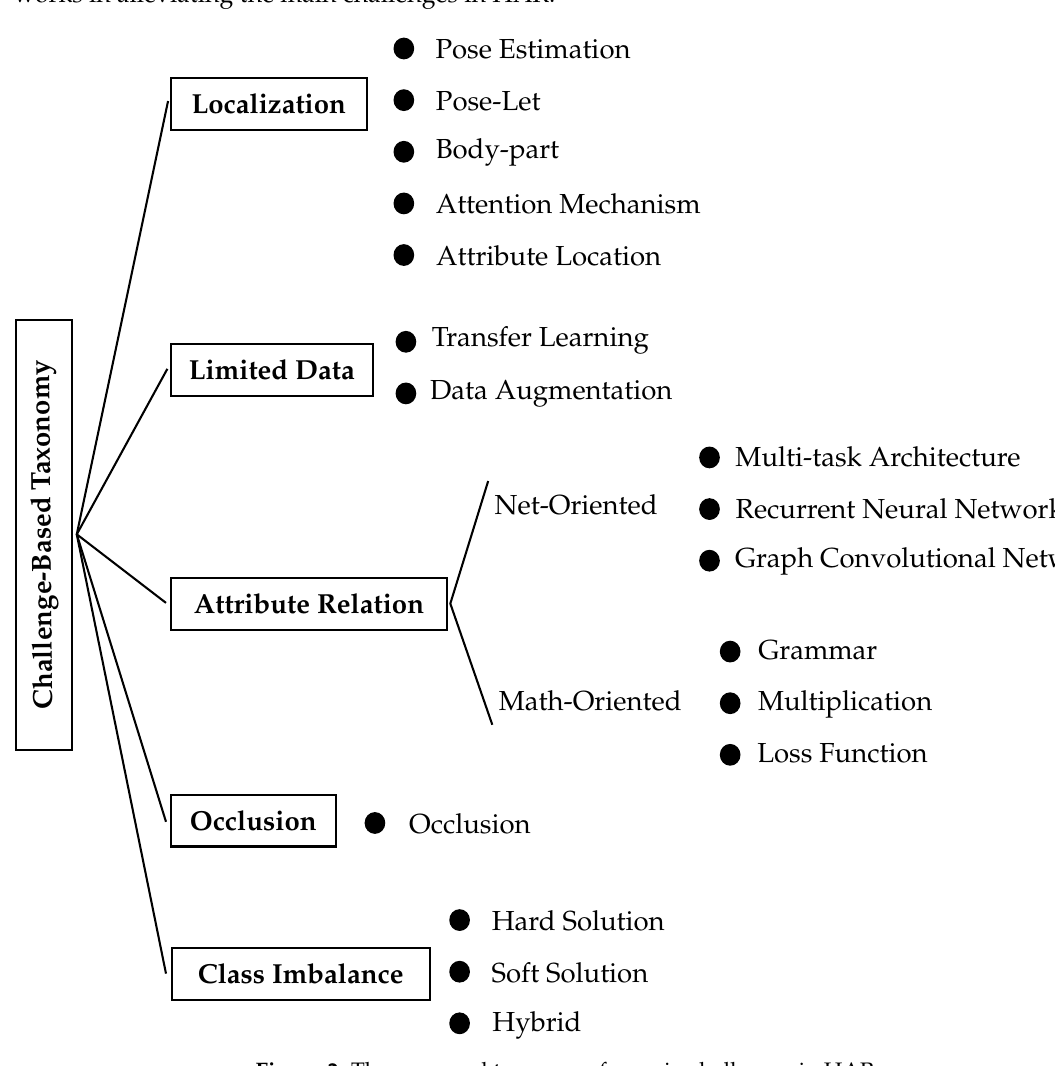
Figure 2. The proposed taxonomy for main challenges in